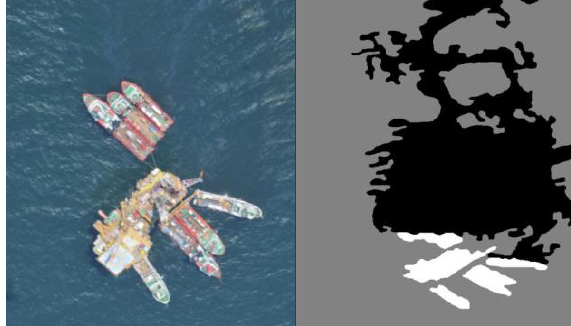
Figure 2. The field aerial photo and validation map （ black is oil film, gray is seawater, and white is working ship and platform